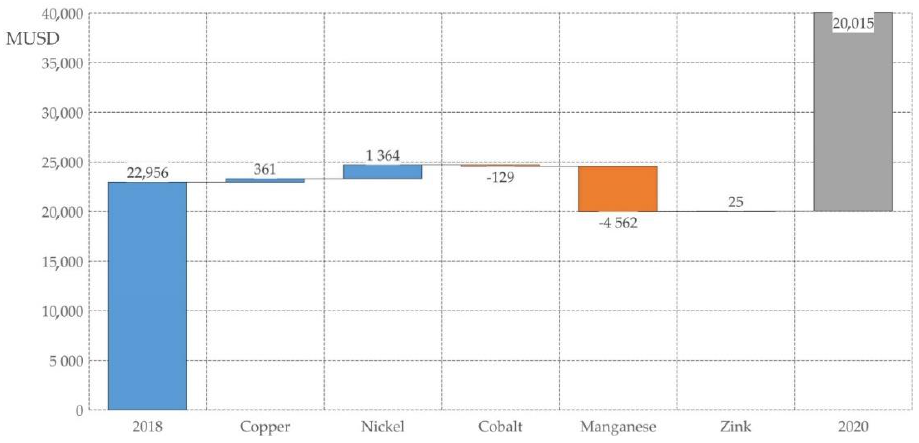
Figure 11. Aggregated revenue change based on HPAL technology (MUSD).